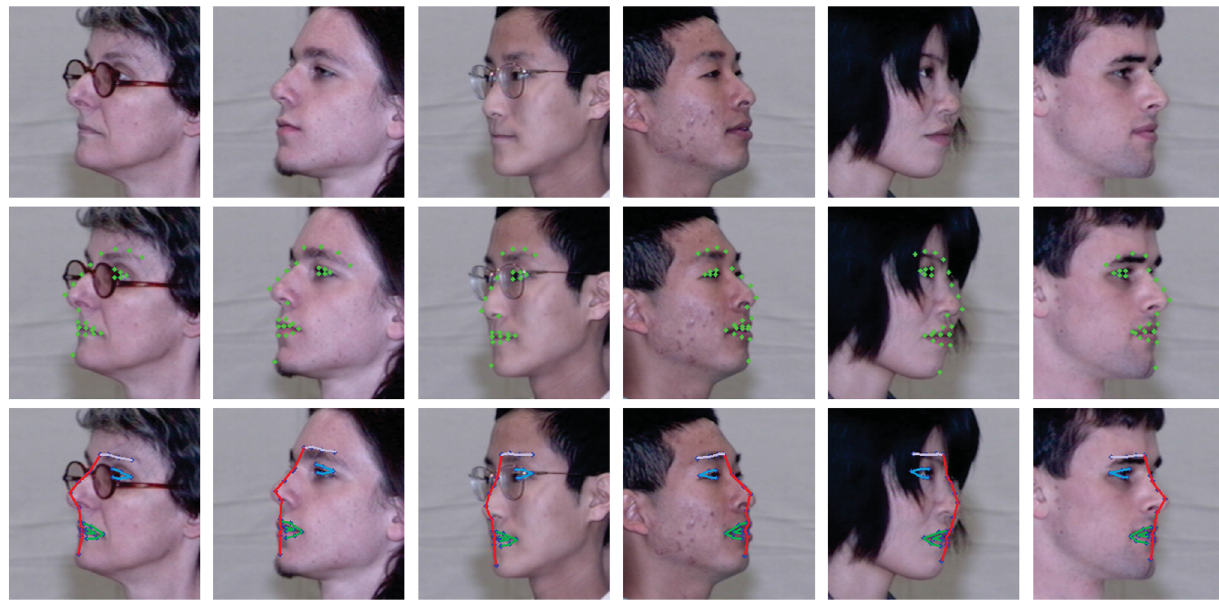
Fig. 4 Qualitative evaluation of C-Net. Top to bottom: original images, ground-truth profile landmarks, and the results from C-Net.